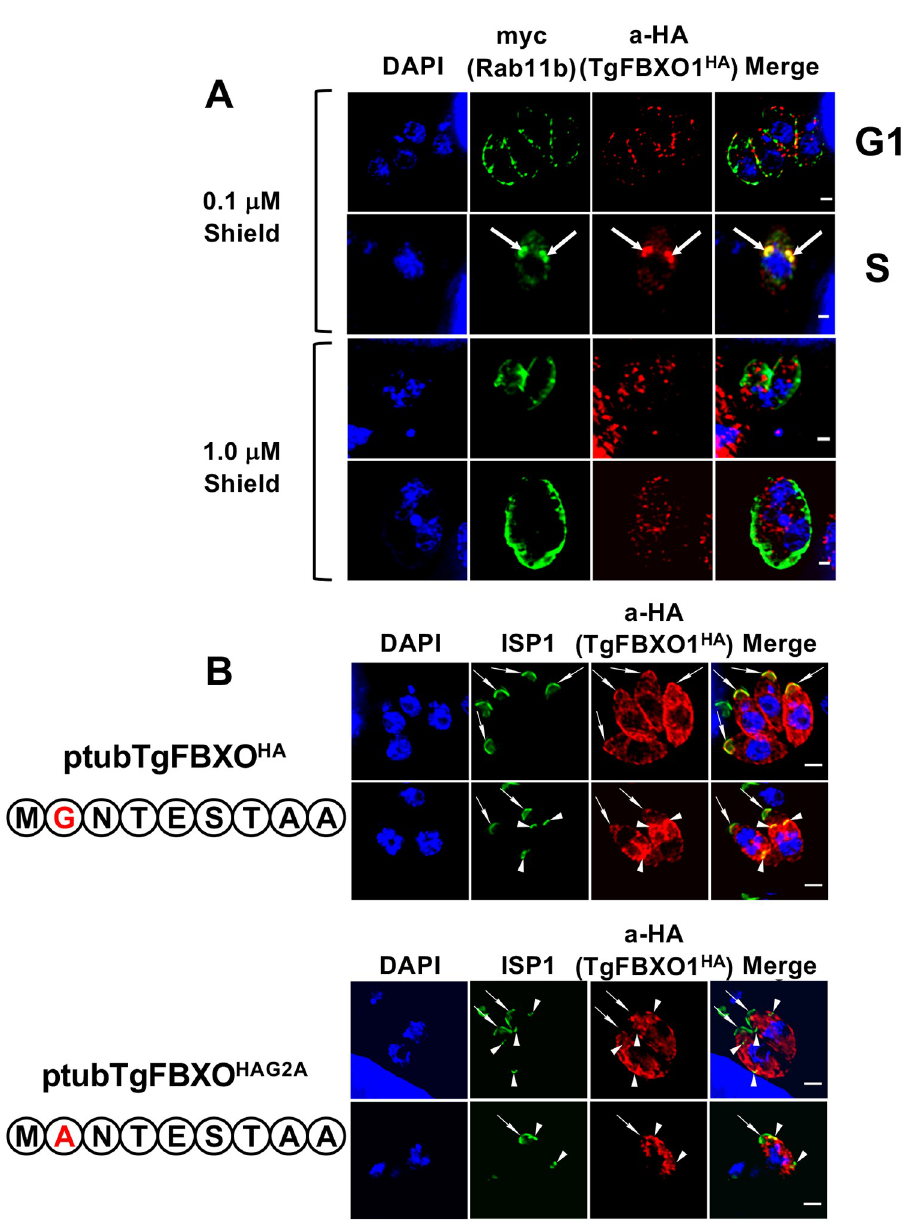
Fig 6. TgFBXO1 is recruited to the DCS in a Rab11b-dependent manner. (A) . TgFBXO1 HA -expressing parasites were transiently transfected with p5RT70DDmycRab11b-HXGPRT expression construct and then grown in the presence of Shield-1 (0.1 μ M—low level expression or 1 μ M–high level expression) reagent for 48 h. Cells were then fixed and stained to detect TgRab11b or TgFBXO1. Arrows highlight apparent colocalization of TgRab11b with the TgFBXO1 apical structures. Note peripheral TgRab11b and punctate TgFBXO1 localization in parasites treated with 1 μ M Shield- 1. Bars = 2 μ m. (B) . Parasites were transiently transfected with wild-type (ptubTgFBXO1 HA ) or myristoylation mutant (ptubTgFBXO1 HAG2A ) TgFBXO1 expression constructs, fixed 48 h later, and stained to detect ISP1 and TgFBXO1. Arrows highlight position of ISP1 apical caps and arrowheads highlight DCS structures. Bars = 2 μ m. Besides IMC development, the DCS also promotes assembly of the daughter cell subpellicu- lar microtubules. To examine whether microtubule assembly is affected in TgFBXO1-depleted parasites, HA(ATC) TgFBXO1 parasites were grown in the absence or presence of ATC and then newly assembled microtubules were imaged using anti-acetylated tubulin antibodies. In